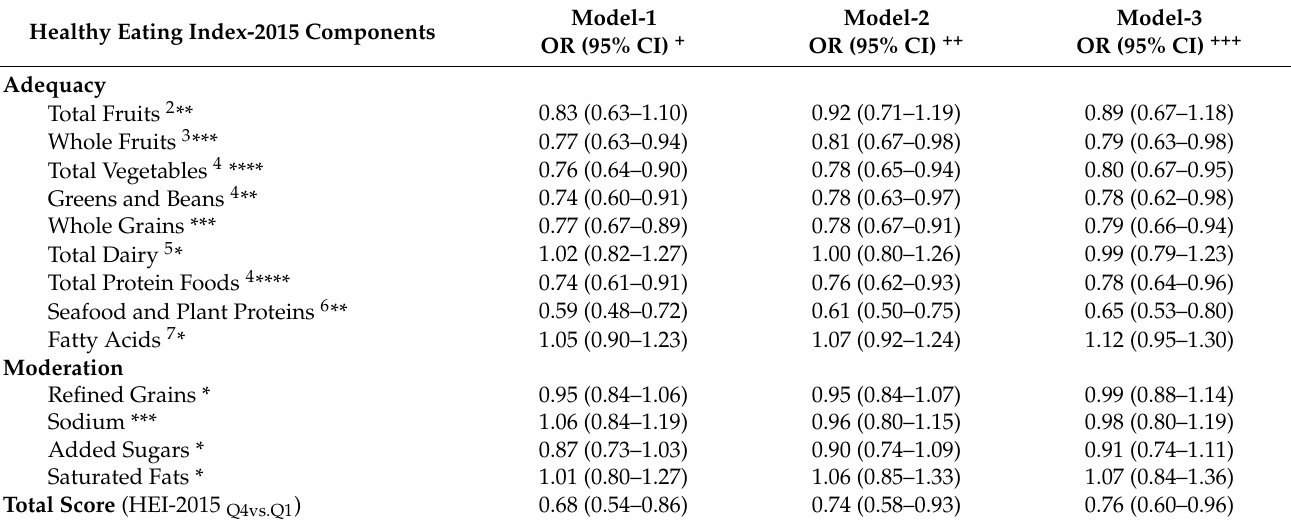
Table 3. Odds Ratios between health eating index 2015 (HEI-2015) components and total scores and low grip strength. U.S. adults (Age 20–80 years) NHANES 2011–2014. n =